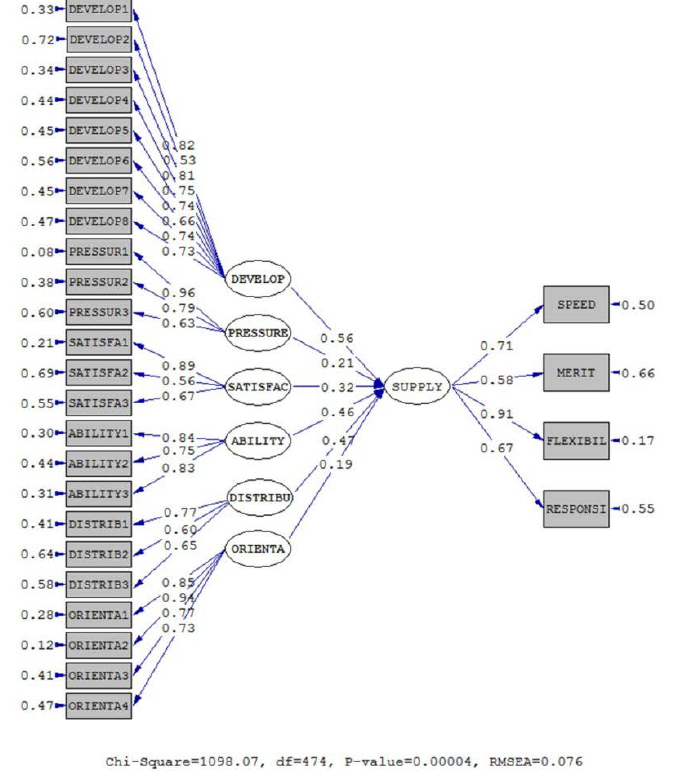
Fig. 3. The results of standard coefficients on SEM implementation